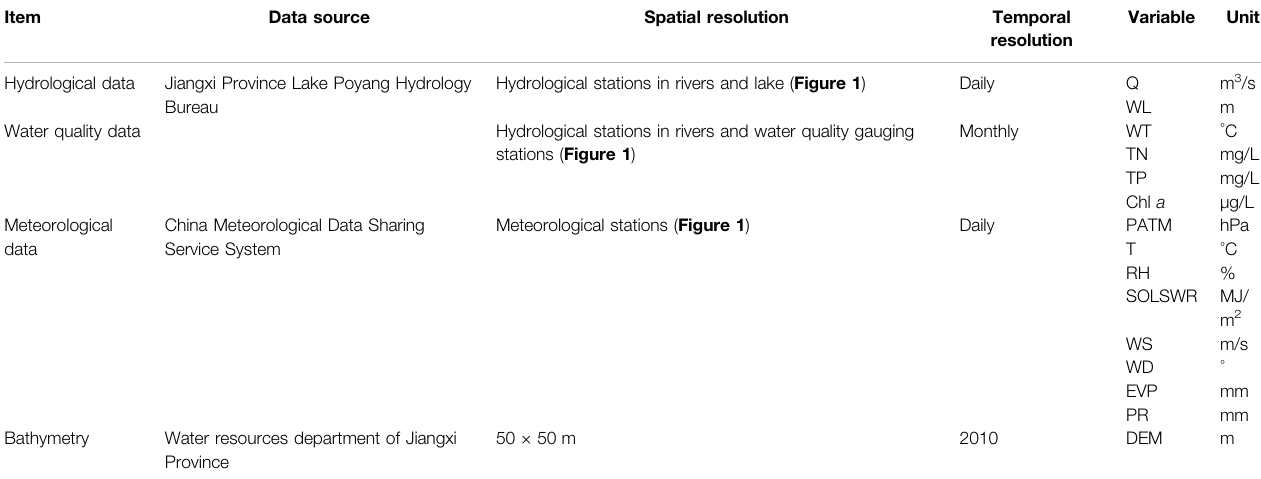
TABLE 1 | Data used in hydrodynamic and water quality modeling.